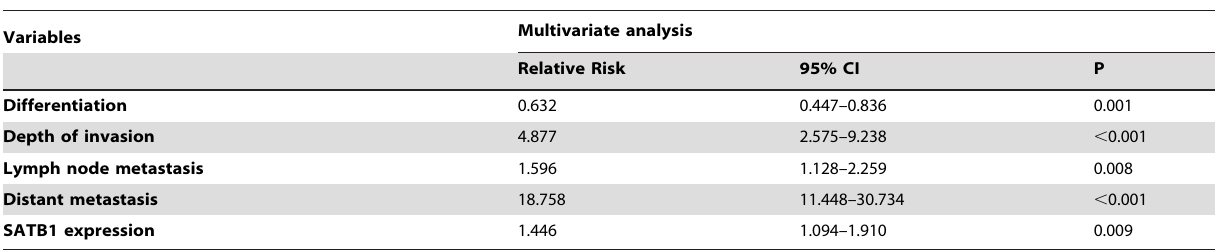
Table 3. Cox proportional hazard regression model